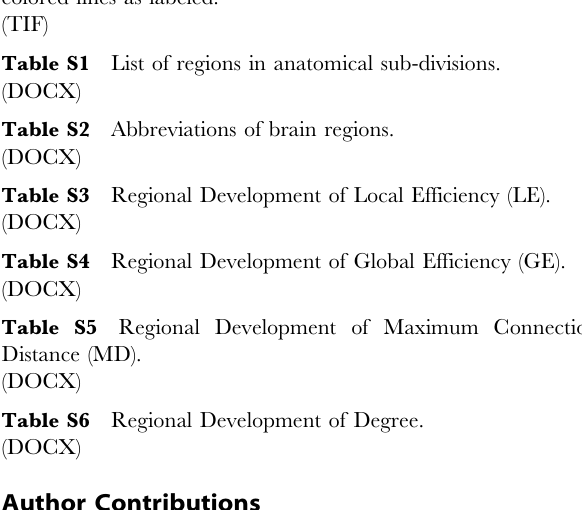
Figure S12 The local efficiency (LE) curves in response to simulated random errors and targeted attacks across the cost range of 10% , 50% (at a step size of 10%) for all three age groups. The LE curves for all three age groups are generally higher than both the random and scale-free networks across most of the cost range although the random network becomes more comparable with the study cohorts at costs . 40% under targeted attacks. In terms of random errors is minimal but is highly dramatic between neonates and 1 yr olds under targeted attacks. Figure S13 Comparison of brain’s resilience to random errors and targeted attacks with synthetic small-world networks con- structed using the Watts&Strogatz’s model. Ten synthetic networks (90 nodes, cost 10%) with rewiring probability from 0.1 to 1 at a step size of 0.1 were constructed and different resilience measures were calculated. The resilience curves of the synthetic small-world networks are shown in dashed black lines with increasing line width from that of rewiring probability of 0.1 to 1. The corresponding curves of pediatric groups are shown in colored lines as labeled. Table S1 List of regions in anatomical sub-divisions. Table S2 Abbreviations of brain regions. Table S3 Regional Development of Local Efficiency (LE). Table S4 Regional Development of Global Efficiency (GE). Table S5 Regional Development of Maximum Connection Distance (MD). Table S6 Regional Development of